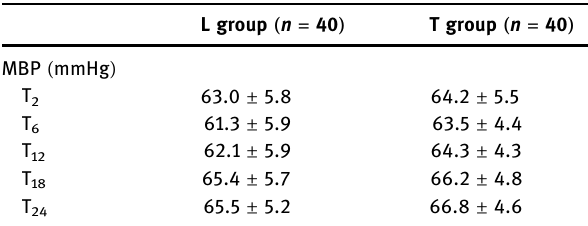
Table A1: Comparison of MBP between the two groups within 24 hours after surgery L group ( n = 40 ) T group ( n = 40 ) MBP ( mmHg )